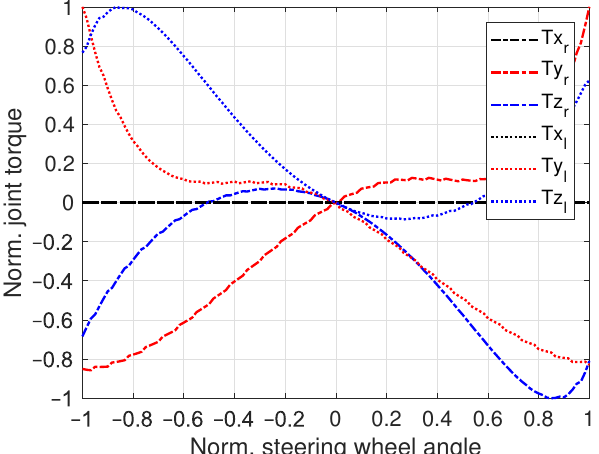
Figure 11. Normalized elbow joint torques over normalized steering wheel angle.